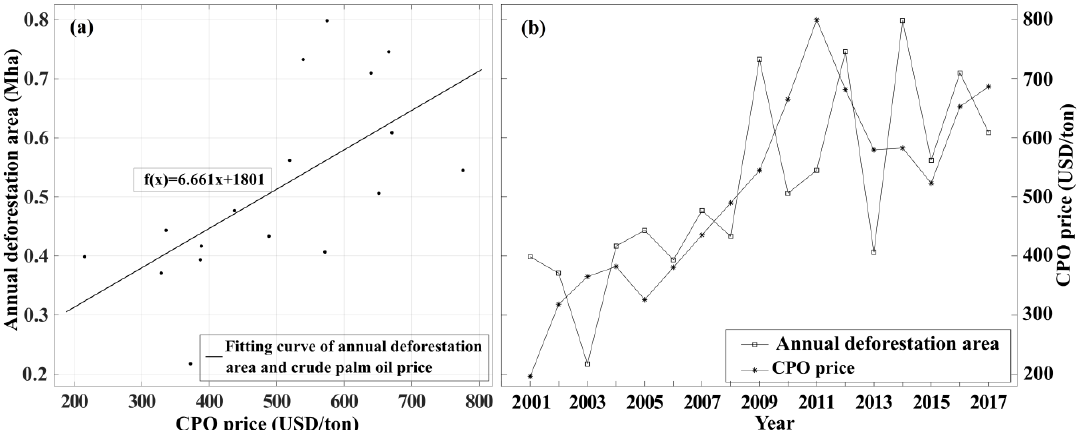
Figure 12. Relationship between forest loss area and CPO price in Malaysia during 2001 – 2017. ( a ) The fitting curve of the price of crude palm oil and the average annual deforestation area and ( b ) the curve of deforestation area and the price of CPO in 2001 – 2017.